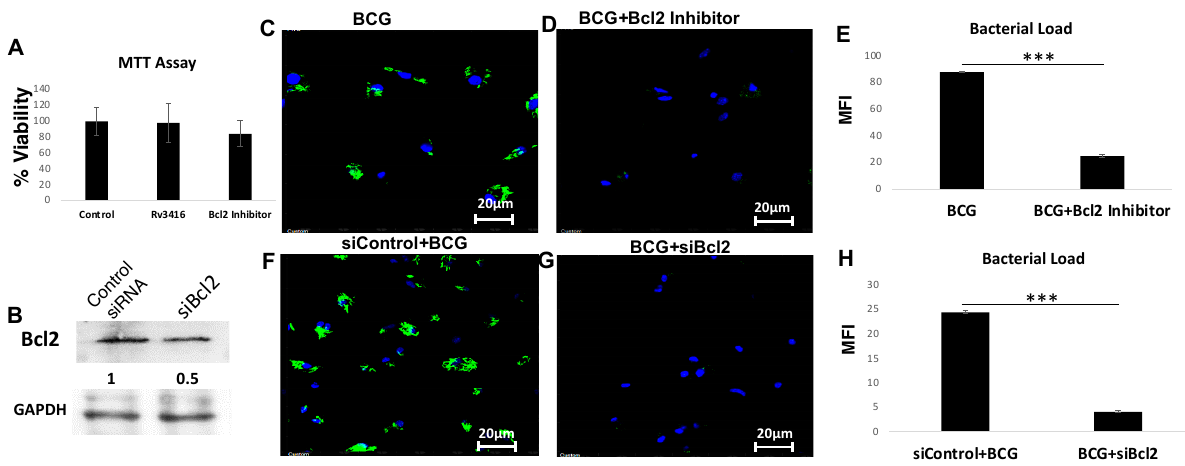
Figure 2: Inhibition of Bcl2 attenuates bacterial survival in BMDCs. Panel A shows cell viability following treatment with either Rv3416 or Bcl2 Inhibitor. Panel B shows knockdown efficiency of siRNA against Bcl2 (siBcl2). Total protein extracts from either Control siRNA or siBcl2 transfected cells were western blotted and probed for levels of Bcl2. Data from one of the three experiments is shown. Values shown below the immunoblot represent relative Bcl2 expression levels normalized to GAPDH in BMDCs as calculated by Densitometric analysis of the immunoblot as detailed in Materials and Methods. For Panels C,D,F&G BMDCs were infected 10 MOI GFP-BCG following either inhibition of Bcl2 with 10 μM Bcl2 Inhibitor (Panel D) or transfection with control siRNAs (siControl Panel F) or siRNA against Bcl2 (siBcl2) (Panel G) for 72h. Cells were processed for confocal microscopy performed using Nikon C2 laser scan confocal microscope. Data were analyzed using the NIS Elements Advanced Research software. Panels C&D and Panels F&G show a representative image of three experiments. Bar charts in Panel E&H represent the mean Fluorescence Intensity of two independent experiments (of 5 fields/experiment). In Panel E, P value between groups BCG and BCG+Bcl2 Inhibitor is P<0.001 and in Panel H between groups siControl+BCG and BCG+siBcl2 is P<0.001. Student’s t-test was performed, *** denotes statistical significance at P